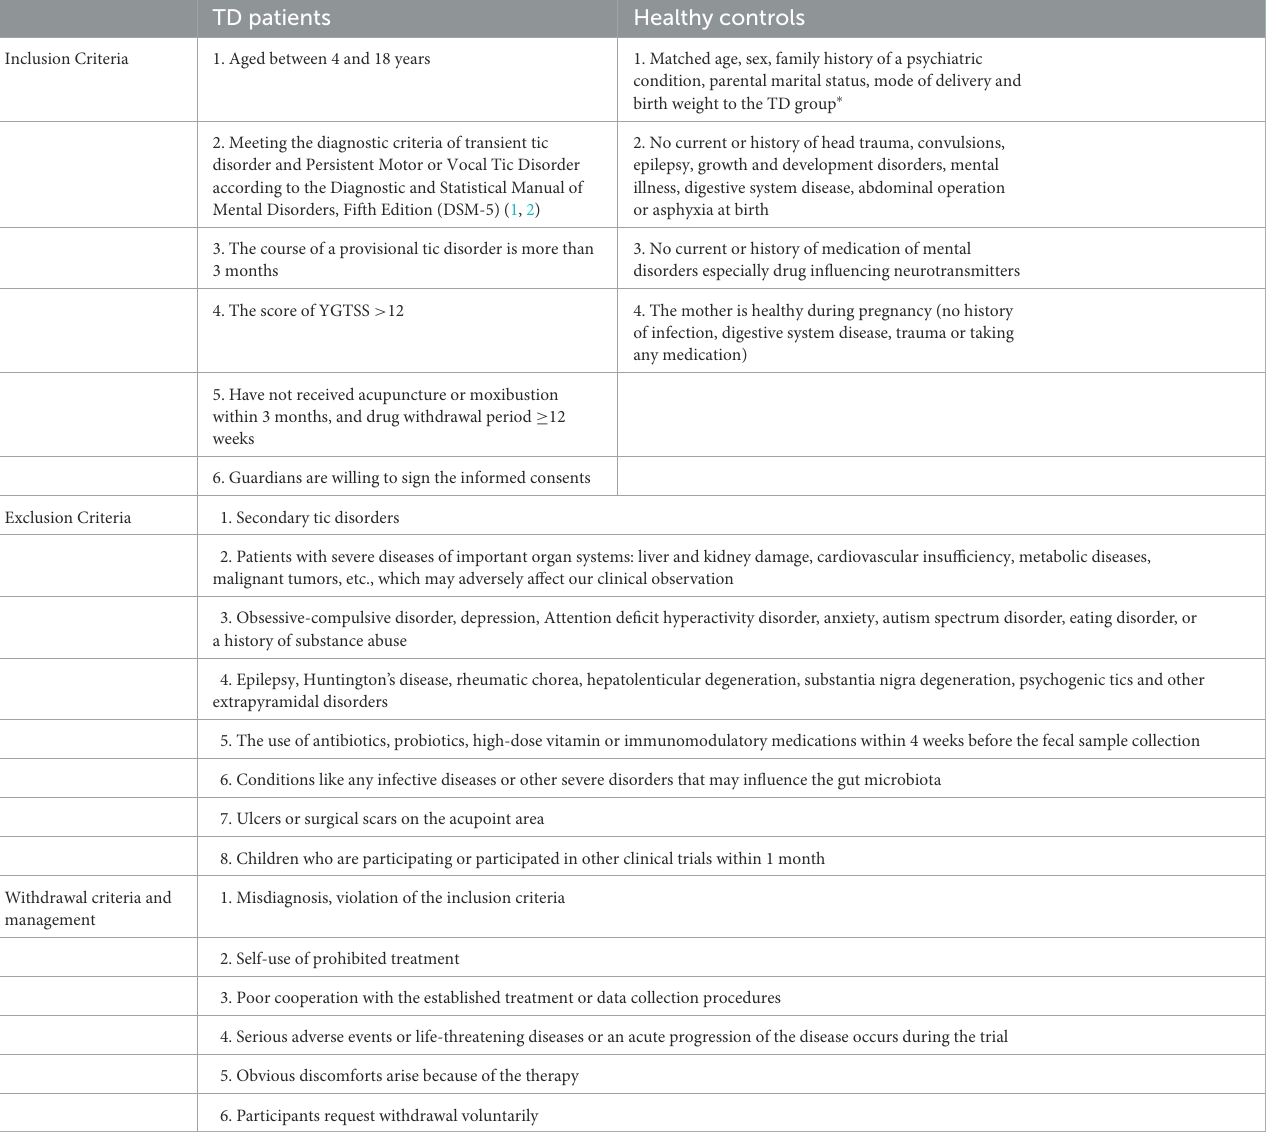
TABLE 1 Eligibility criteria. TD patients Healthy